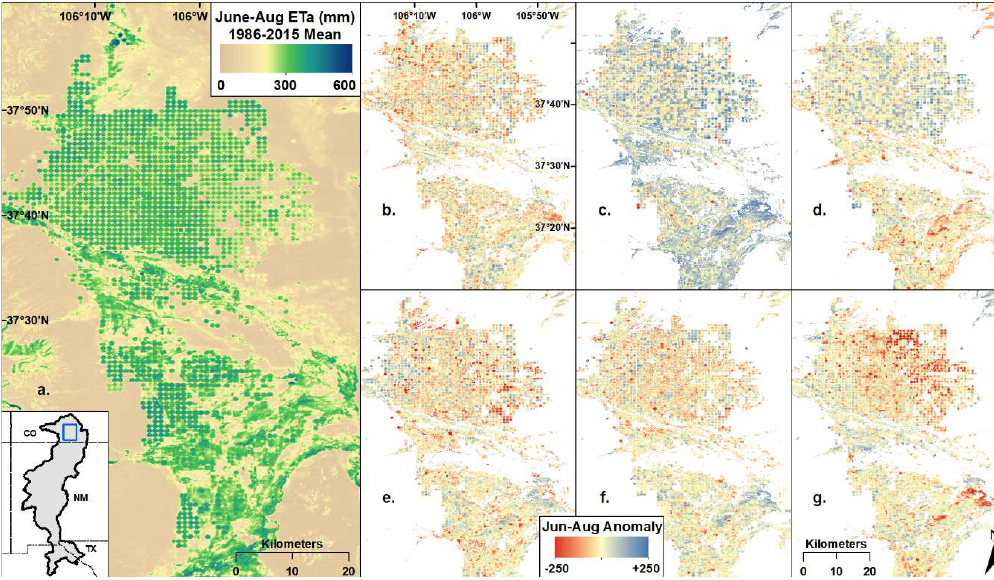
Figure 6. Colorado June–August ETa showing ( a ) 1986–2015 mean ETa (mm), and the annual anomaly (deviation from the mean, mm) on a 5-year interval for ( b ) 1990, ( c ) 1995, ( d ) 2000, ( e ) 2005, ( f ) 2010, and ( g ) 2015.